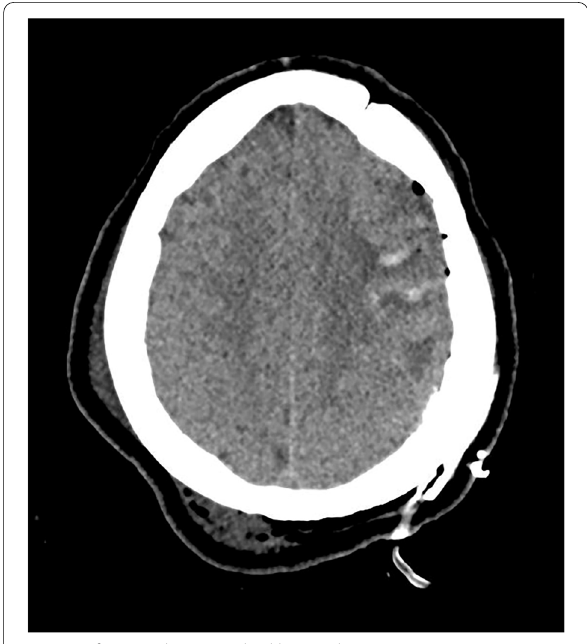
Fig. 3 Left cortical intracerebral hemorrhage. Non‑contrast CT showing left cortical intracerebral